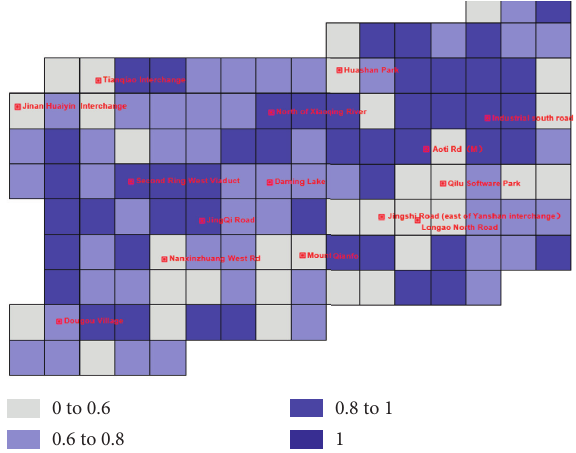
Figure 13: The distribution of coordinated development level u of two systems.